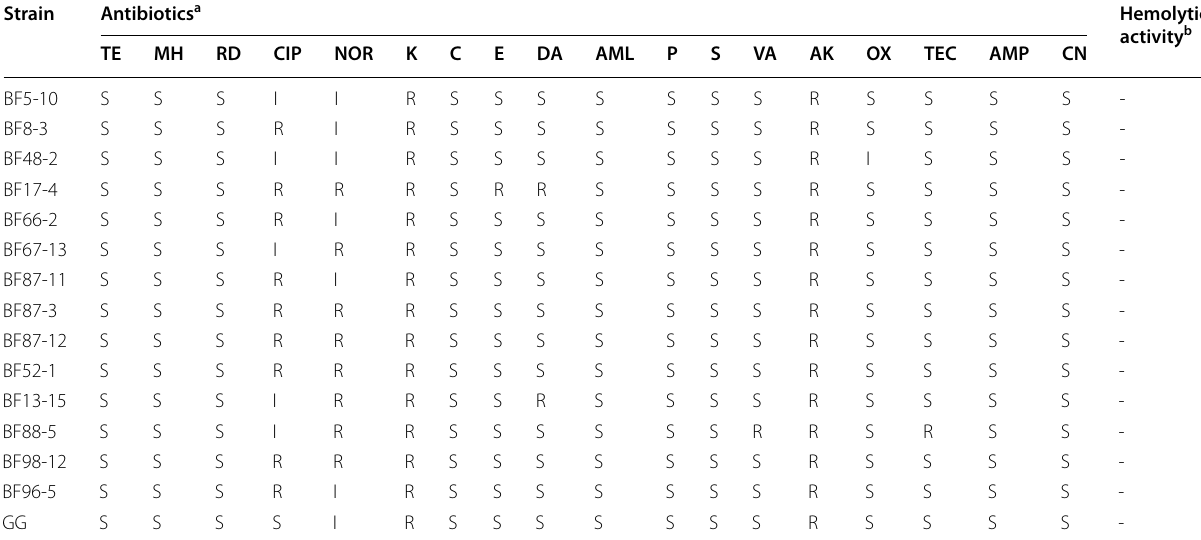
Table 2 Antibiotic-resistant and hemolytic activity of the Bifidobacterium strains Strain Antibiotics